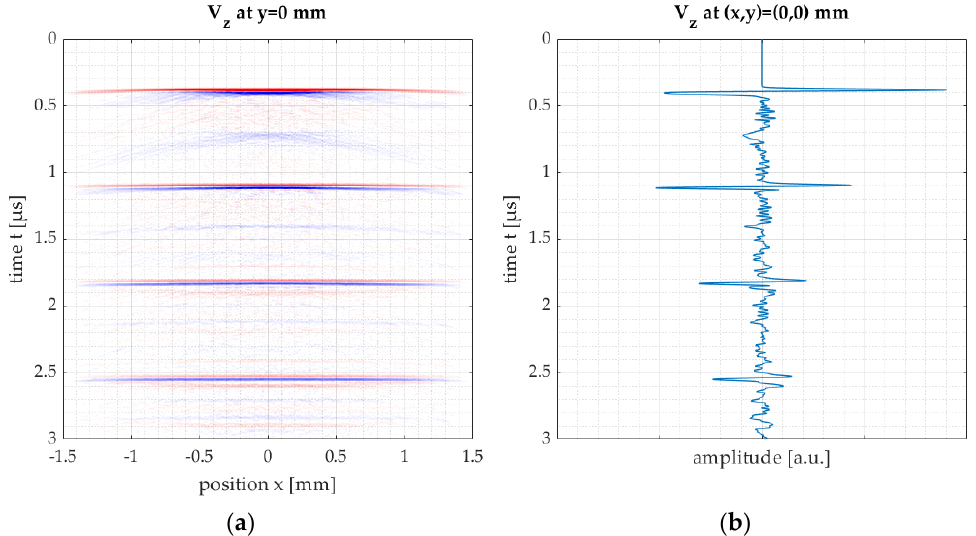
Figure 7. A cross-section of a recording ( a ) along a line (red colors denote a positive signal and blue a negative); and ( b ) from a single receiver in the center.